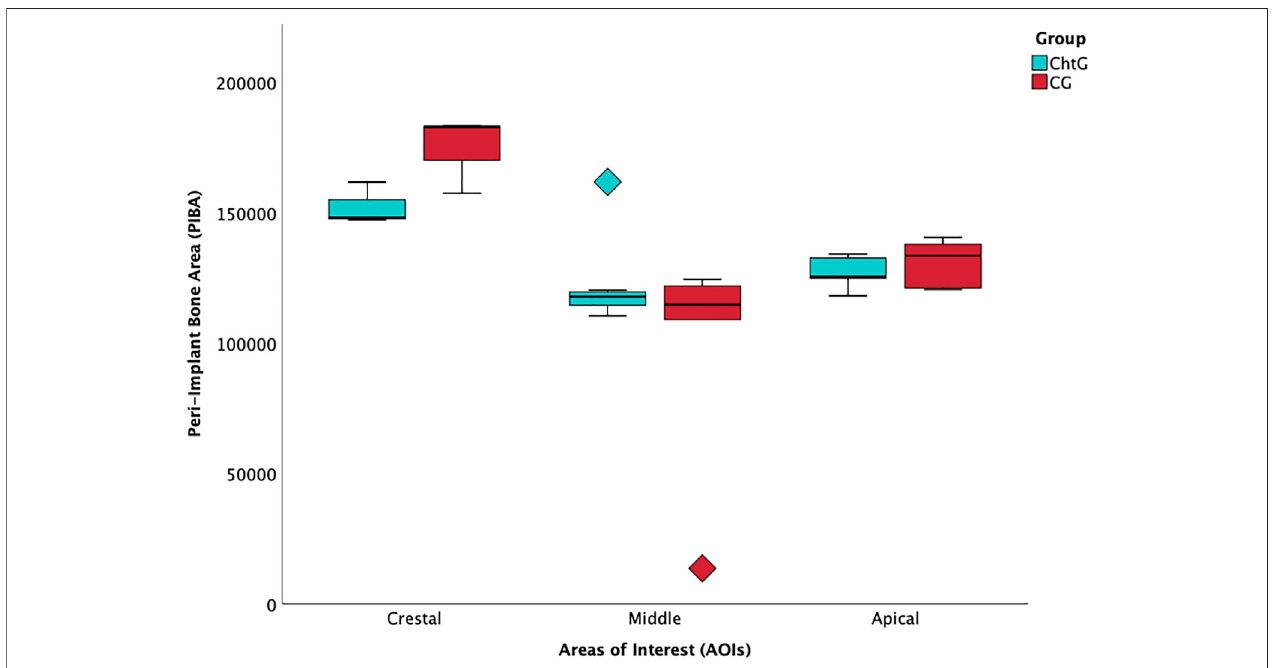
FIGURE 6 | Boxplot of peri-implant bone area (PIBA) values at crestal, mid and apical levels.